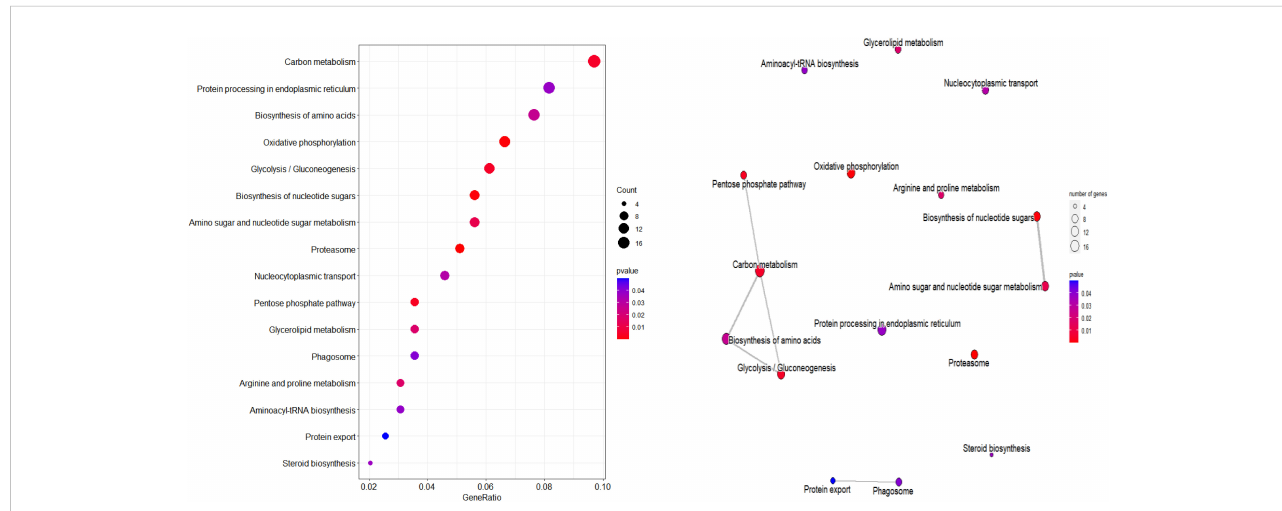
FIGURE 6 KEGG pathway plot and Emapplot of DEPs in group 3. According to the KEGG database: “ GeneRatio ” means the ratio of the number of differentially expressed genes under this pathway term to the number of annotated genes under the pathway term. The larger the value is, the greater the enrichment degree is in kegg and